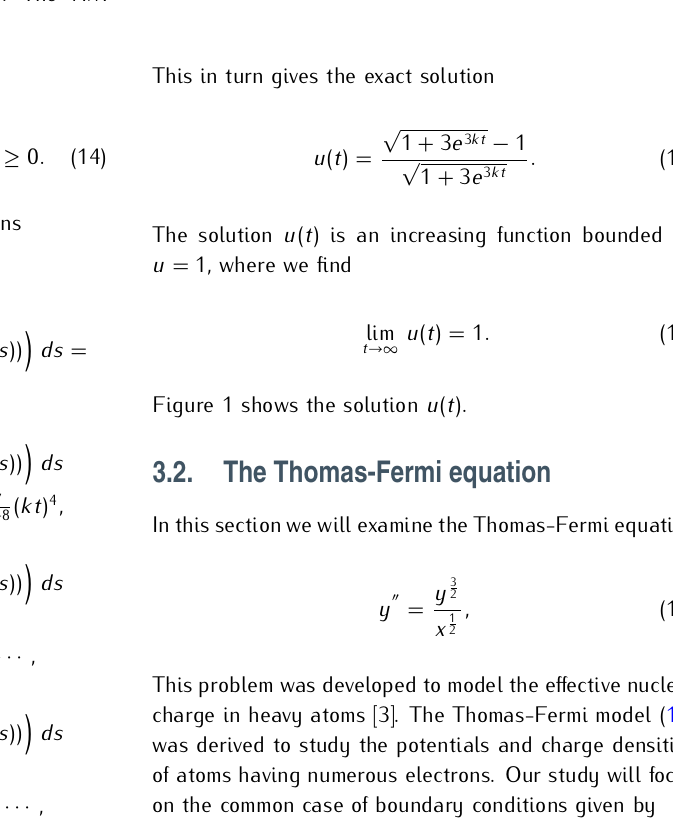
Figure 1. The solution u ( t ) for k = 0 . 25 , and 0 ≤ x ≤ 20